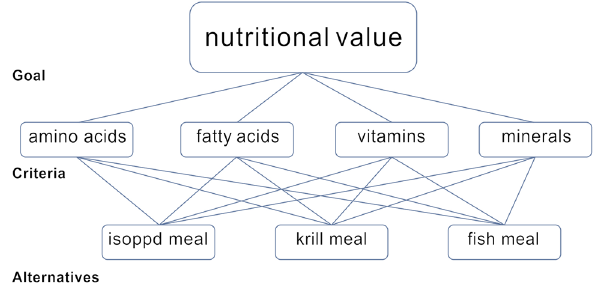
Figure 2. Analytical hierarchy process model of nutritional value for L.exotica , krill meal and fish